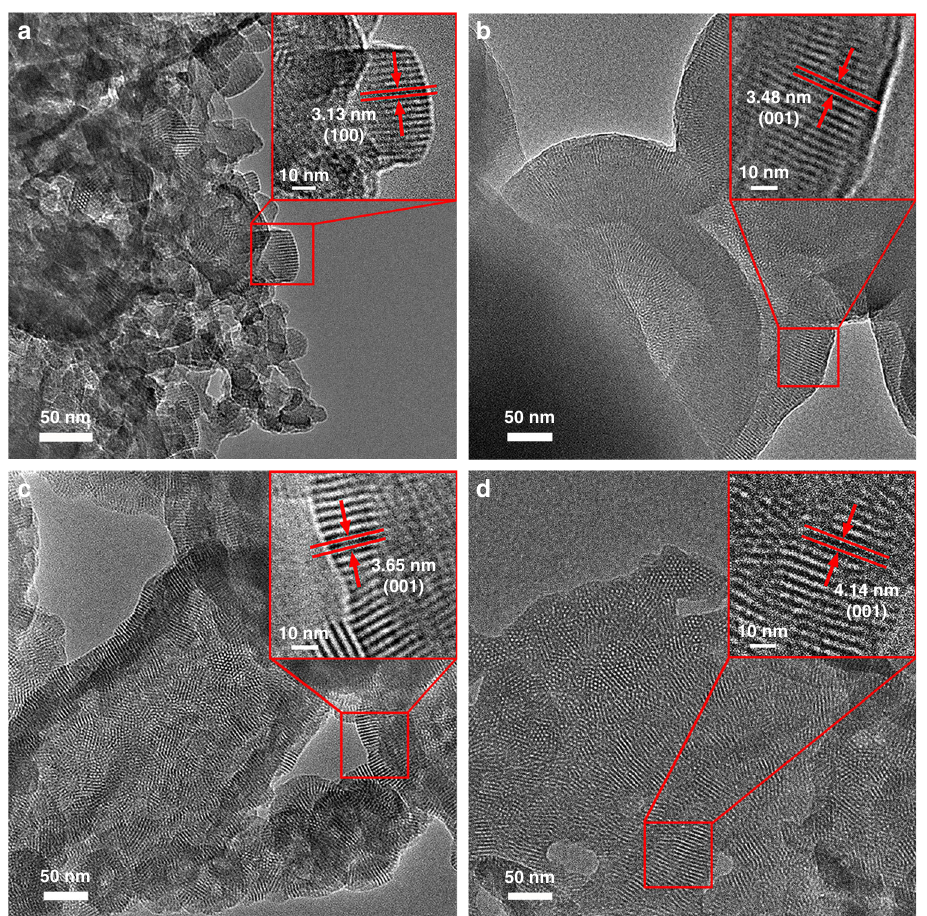
Fig. 6 TEM analysis. TEM images of a Tri-COF-DAB, b Tetra-COF-DAB, c Tri-COF-BZ, and d Tetra-COF-BZ. The insets in the upper right corners are magni fi ed images from their corresponding red PXRD pattern of the predicted tetrad-pore COF with AA stacking kcal/mol) further supports that Tetra-COF-DAB adopts AA (Fig. 3b), con fi rming that Tetra-COF-DAB holds a structure stacking. Pawley re fi nement gave lattice parameters of a = 44.94 bearing four different kinds of pores. The lower total energy of Å, b = 3.69 Å, c = 40.89 Å, α = γ = 90°, β = 120°, with R wp = 1.59% and R p = 1.03%. The difference plot indicates that PXRD AA stacking (265.64 kcal/mol) than that of AB stacking (623.67